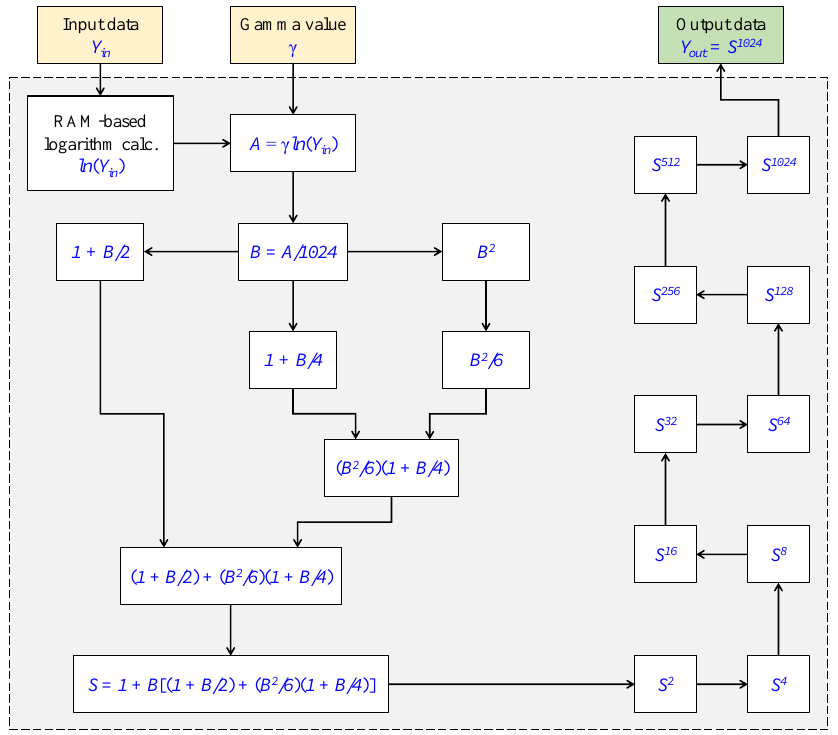
Figure 4. Computational flow of the floating-point